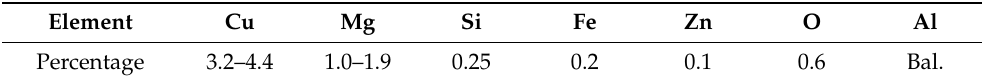
Table 1. Chemical compositions of 2009 aluminum alloy employed in this study (wt%). Element Cu